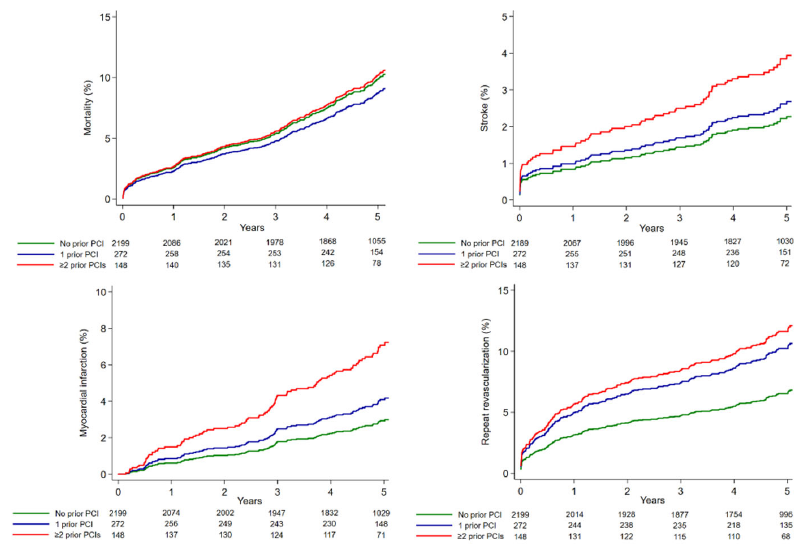
Figure 2. Adjusted estimates of outcomes in patients without prior PCI, with 1 prior PCI and with ≥ 2 prior PCIs.